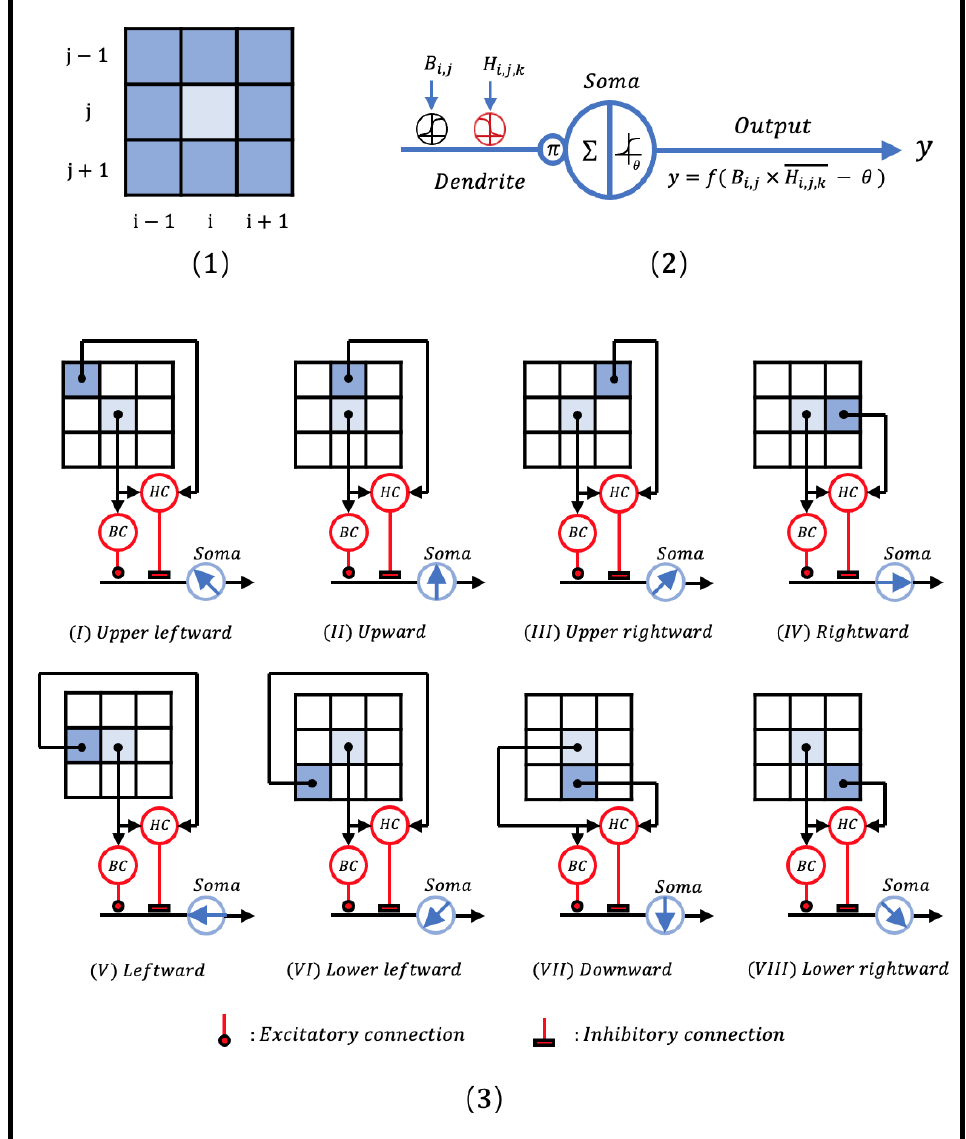
Figure 4. The structure of motion direction-selective pathway in the visual system: ( 1 ) the local receptive field and its position coordinate code when scanning; ( 2 ) the LMDN model based on DNM (black synapse: excitatory connection; red synapse: inhibitory connection); ( 3 ) DS circuits for eight types of LMDNs with different motion